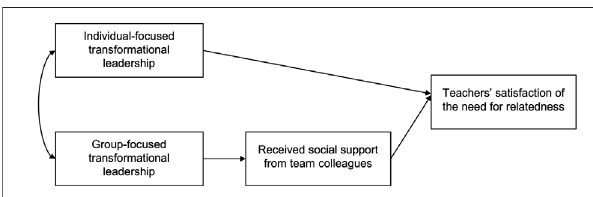
FIGURE1| Hypothesizedpathsbetweendual-focusedtransformational leadership, social support, and satisfaction of the need for